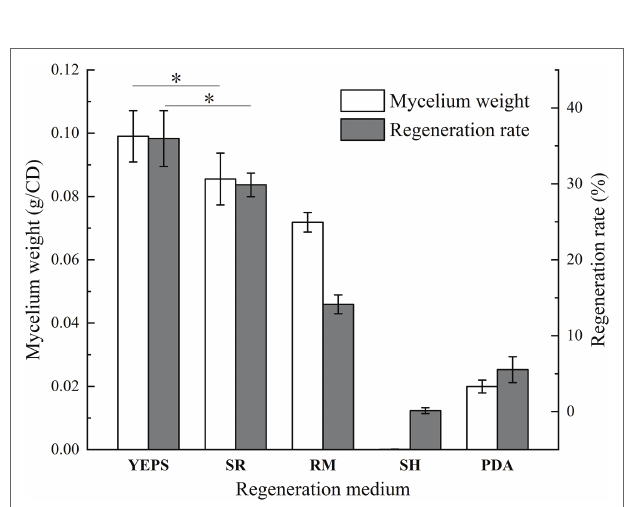
FIGURE 7 | The wet weight of regeneration mycelium and protoplast regeneration rate of strain D-1 ( * p < 0.05).